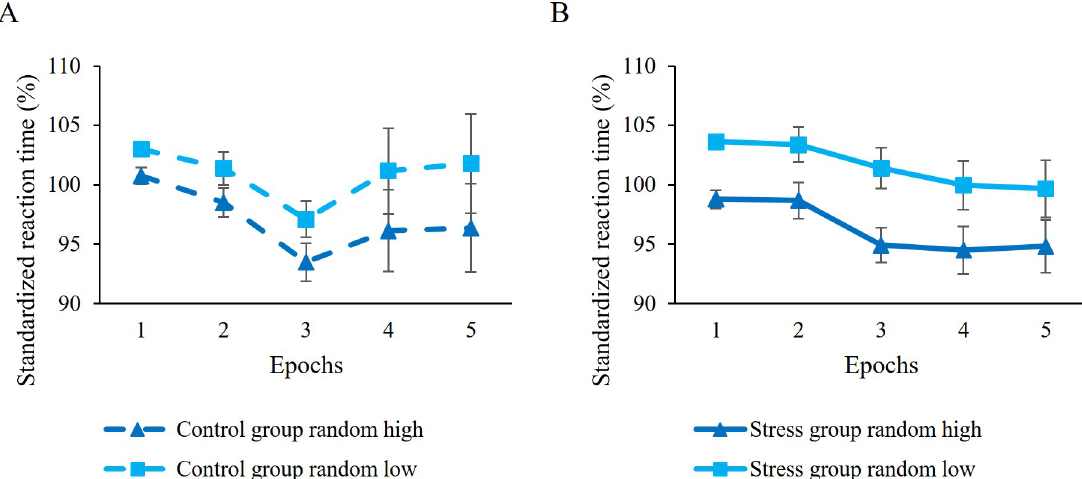
Fig 4. Learning of probability-based regularities in (A) control and (B) the stress groups. Dashed lines represent the control group, continuous lines represent the stress group. Blue lines with triangle symbols indicate standardized reaction times on the random high trials, light blue lines with square symbols indicate standardized reaction times on the random low trials. Learning of probability-based regularities is quantified by the distance between dashed and continuous lines, greater distance represents better learning. Error bars denote the